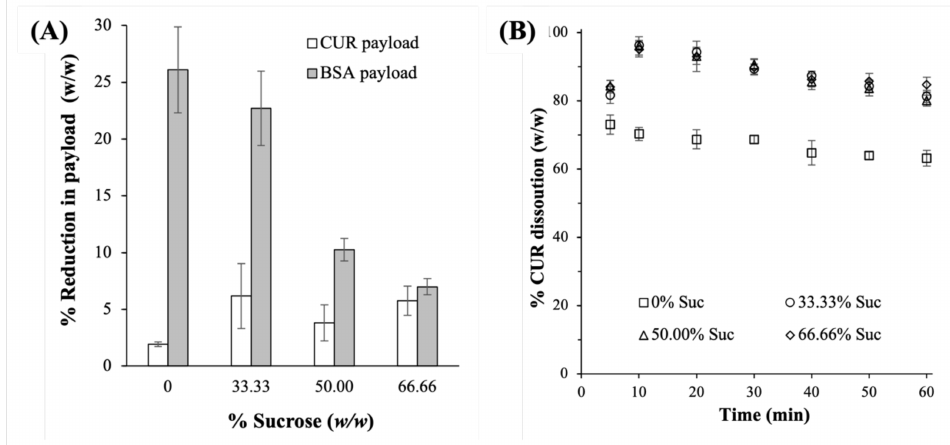
Figure 6. ( A ) Reduction in the CUR and BSA payloads and ( B ) CUR dissolution profiles of the lyophilized CUR-BSA nanoplexes after 30-day exposures at 40 ◦ C and 75%